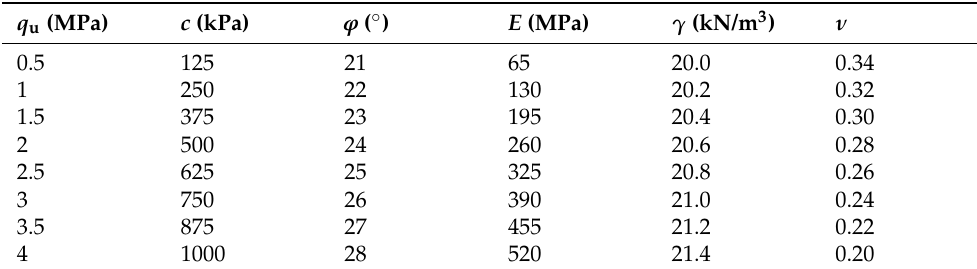
Table 4. Physical and mechanical parameters of cement-improved